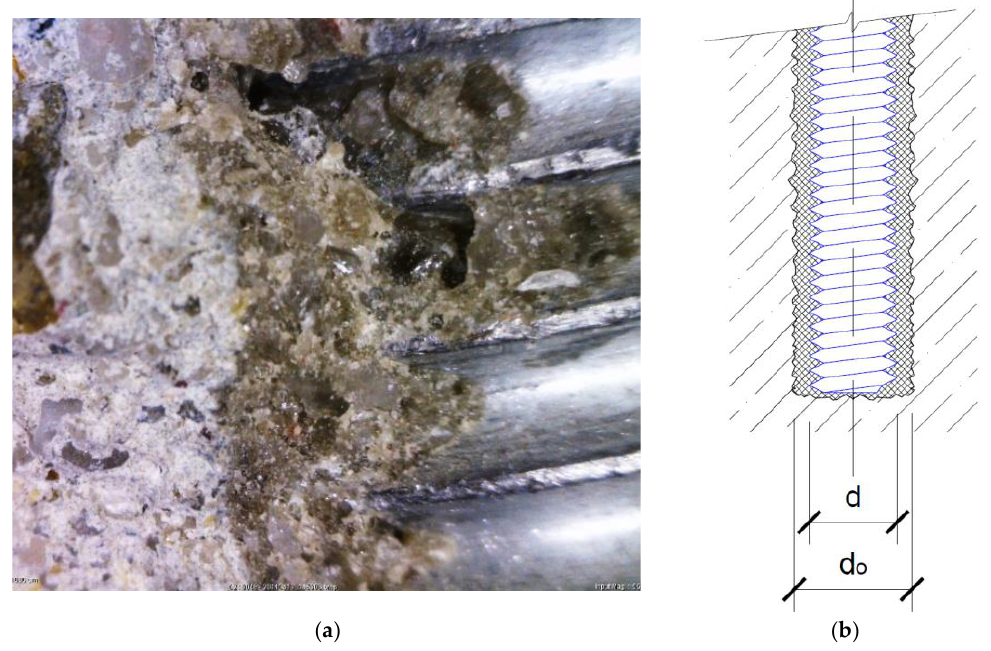
Figure 2. ( a ) Microscope photo of bonded anchor — contacts between materials, from the left-hand side — concrete/adhesive/steel anchor bolt; ( b ) Interface concrete – adhesive defined by outer diameter of drilled hole d 0 and interface adhesive – anchor defined by outer diameter of the anchor bolt d .